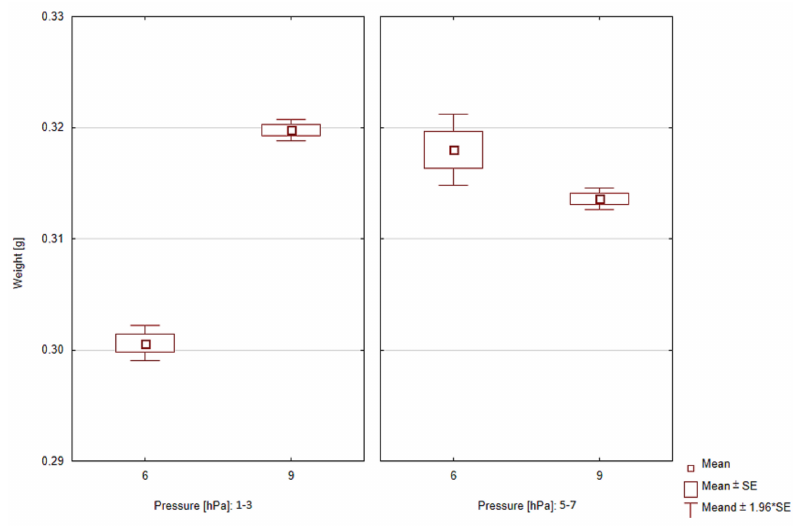
Figure 1. The effect of pressure and flow rate of the carburising mixture (100% C 2 H 2 ) on the increase in the mass of carbon in the low-pressure carburised surface layer.